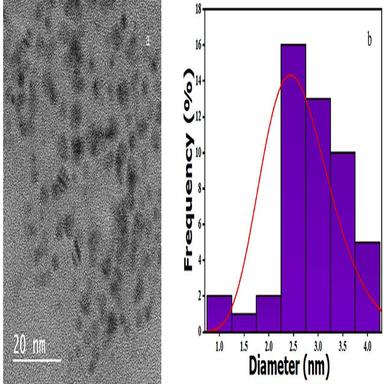
TEM images displaying spherical shaped HPMC / copper nanobiocomposites measuring 14 nm width and 2.5 nm length (a); the histogram in the graph illustrates the size distribution of particles within the HPMC /copper nanobiocomposites (b).